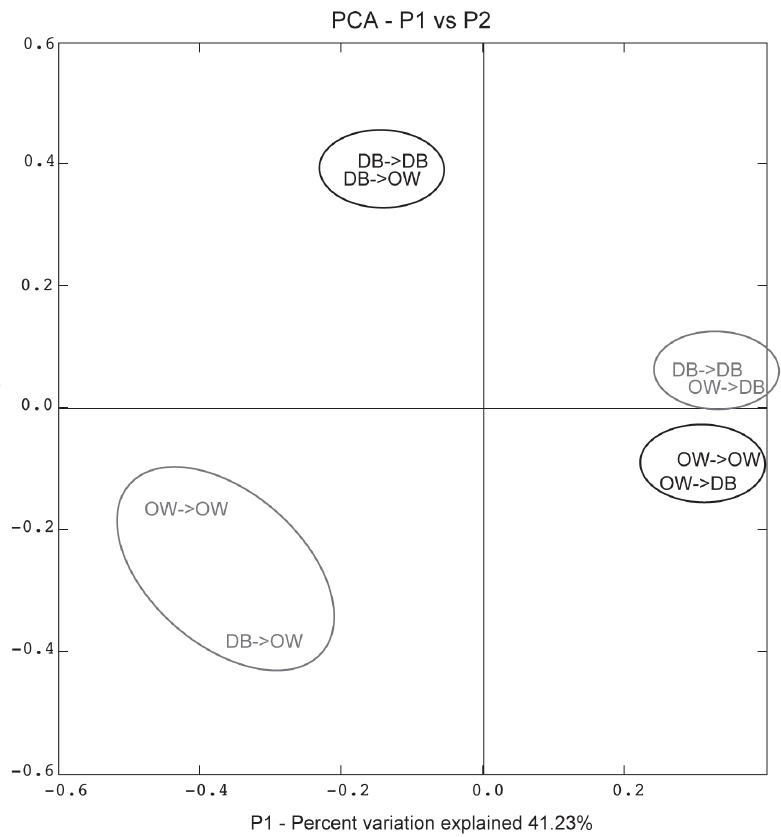
Figure 4. Ordination of Vibrio communities from all different transplants. Origin_Transplant site: DB- . DB, DB- . OW, OW- . DB, OW- . OW at the beginning (June in Black) and end (September in Grey) of the experiment. Shown are the first two principle coordinates from PCoA implemented in web-based UniFrac analysis.